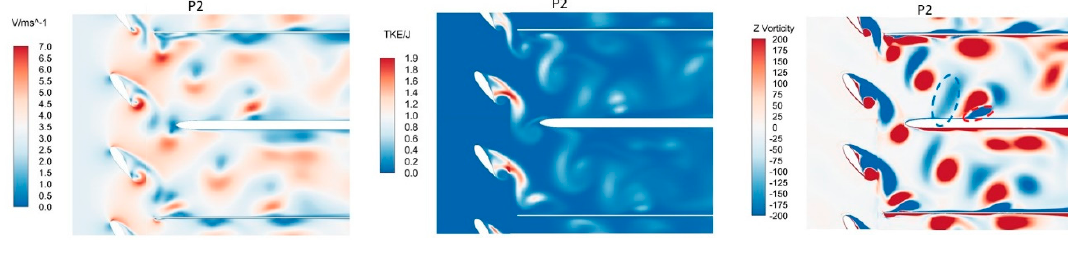
( c ) Contours at phase 3, left: velocity, middle: turbulence kinetic energy, right: z vorticity. Figure 12. Distributions of phase-averaged results at three selected phases at f = 20 Hz.